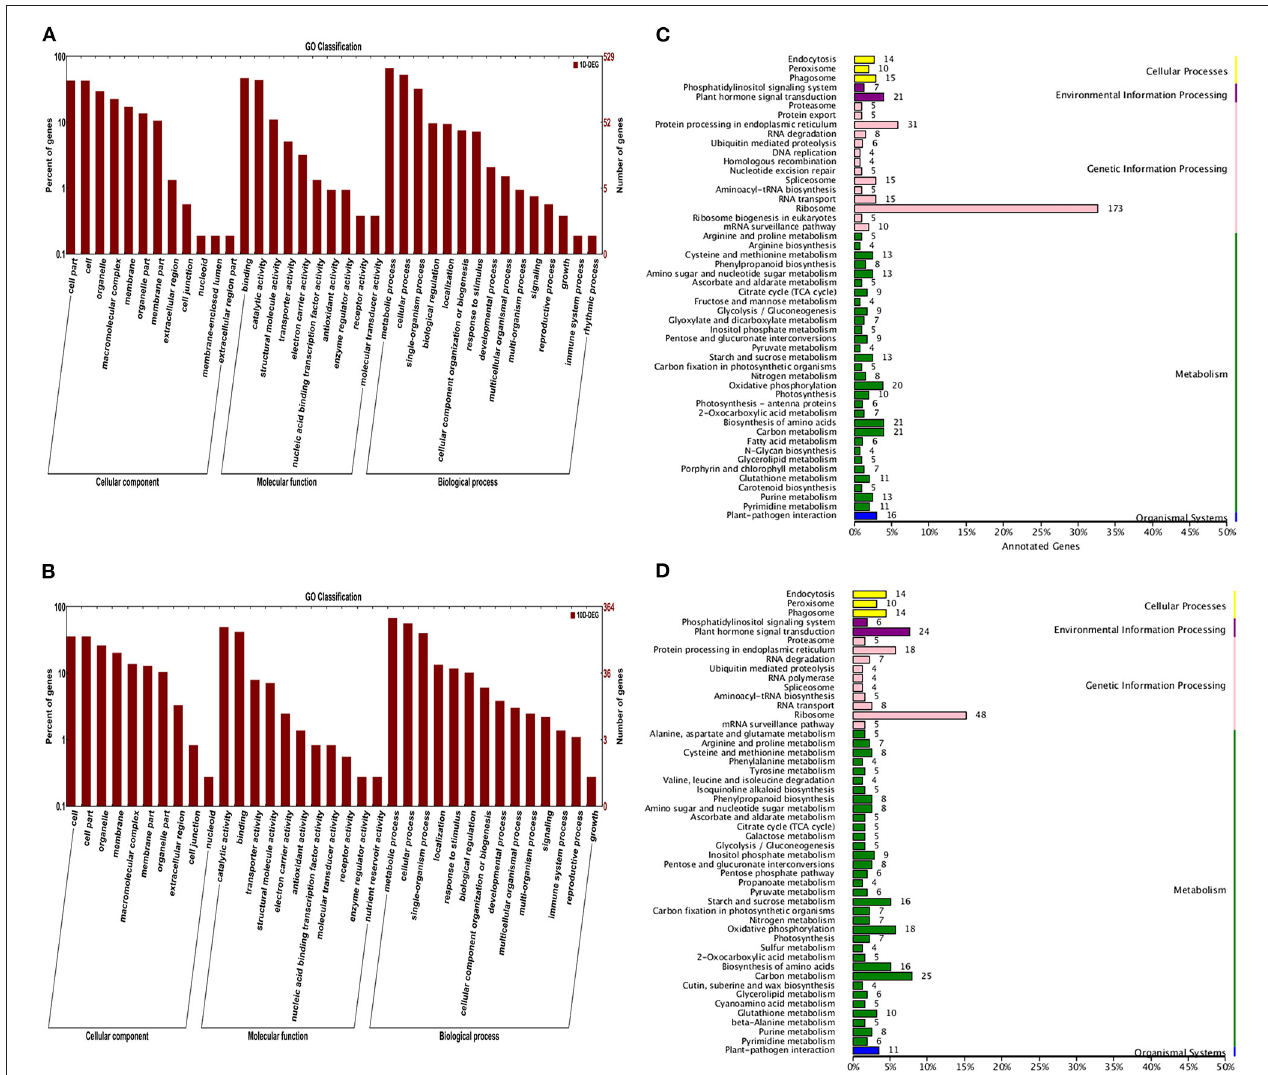
FIGURE 3 | GO category and KEGG pathway enrichment analysis of the annotated DEGs. (A,B) Represented GO category analysis of 1D and 10D DEGs, respectively; (C,D) Represent the KEGG pathway enrichment analysis of 1D and 10D DEGs, respectively.